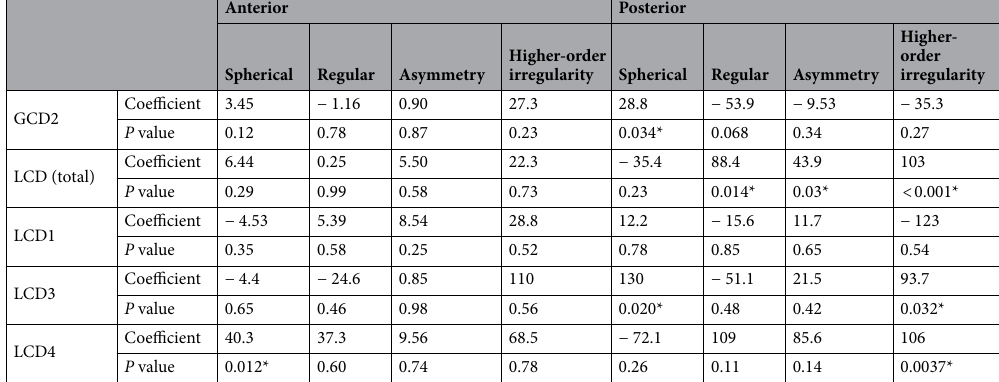
Table 4. Association between central corneal thickness and Fourier components. GCD2 : granular corneal dystrophy type 2, LCD (total): Lattice corneal dystrophy (Includes all subtypes), LCD1 : Lattice